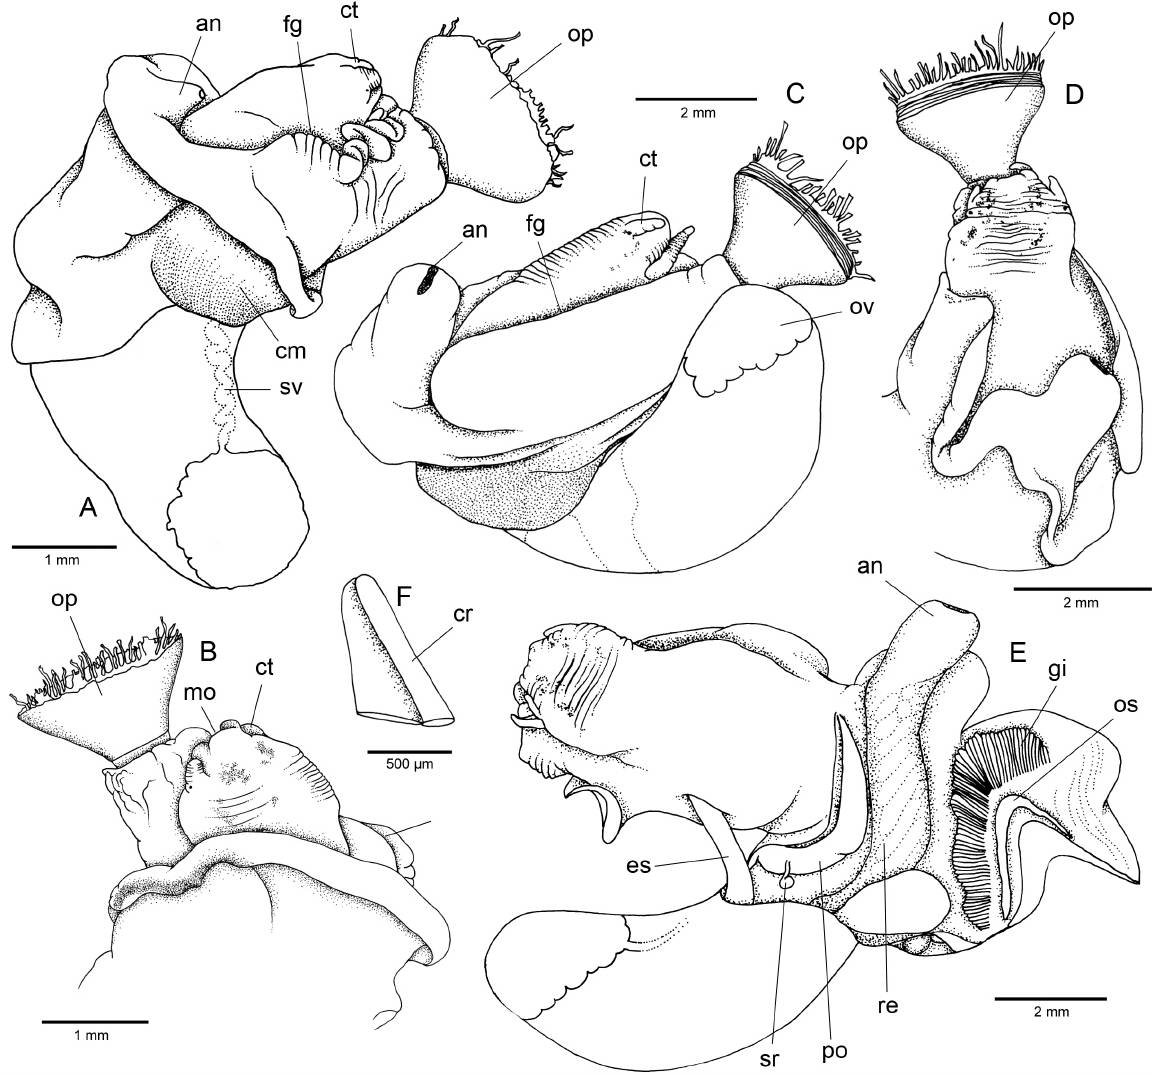
Fig. 3. Anatomy of Novastoa rapaitiensis sp. nov. A–B . Male specimen (holotype, MNHN IM-2000- 27249, Rapa Iti Island, French Polynesia). A . Right view. B . Dorsal view of anterior body. – C . Female specimen, right view (UF 436684, Moorea Island, French Polynesia). – D–E . Female specimen (AM C.464342, Yonge Reef, Australia). D . Dorsal view of anterior body. E . Mantle cavity. – F . Leaflet from mid-section of gill (UF 436684, Moorea Island, French